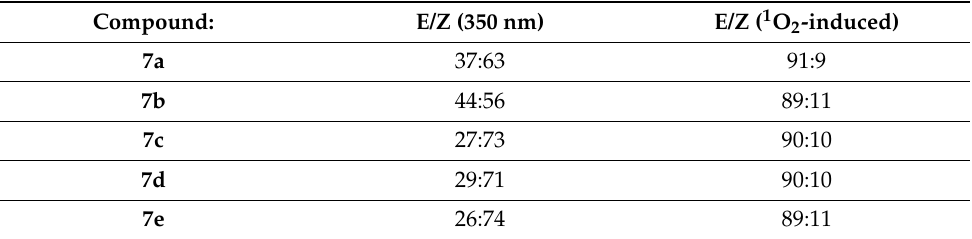
Table 1. Photostationary E/Z composition after 350 nm irradiation in CH 3 CN; E/Z composition after TPP-irradiation (singlet oxygen conditions) in CDCl 3 /O 2